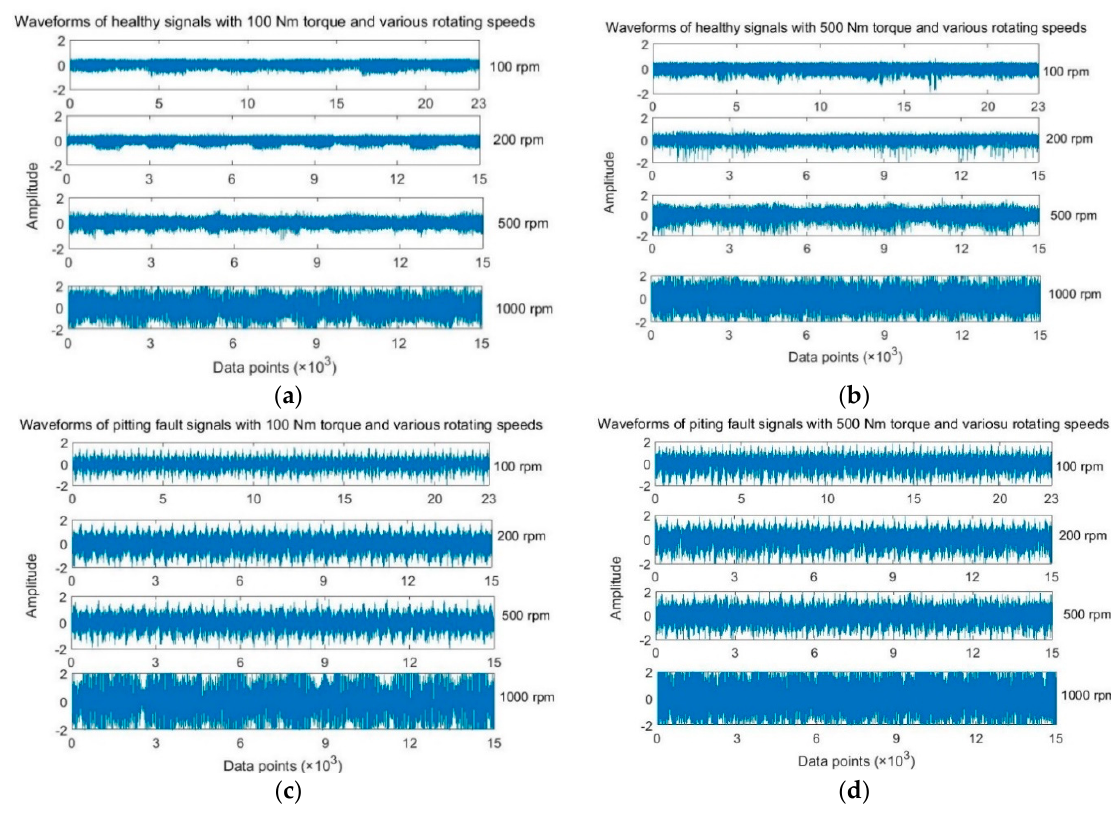
Figure 9. The waveforms of raw vibration data for normal and pitting gear at various rotating speeds under loading conditions of 100 Nm and 500 Nm. ( a )waveforms of healthy signals with 100 Nm; ( b ) waveforms of healthy signals with 500 Nm; ( c ) waveforms of faulty signals with 100 Nm; ( d ) waveforms of faulty signals with 500 Nm.